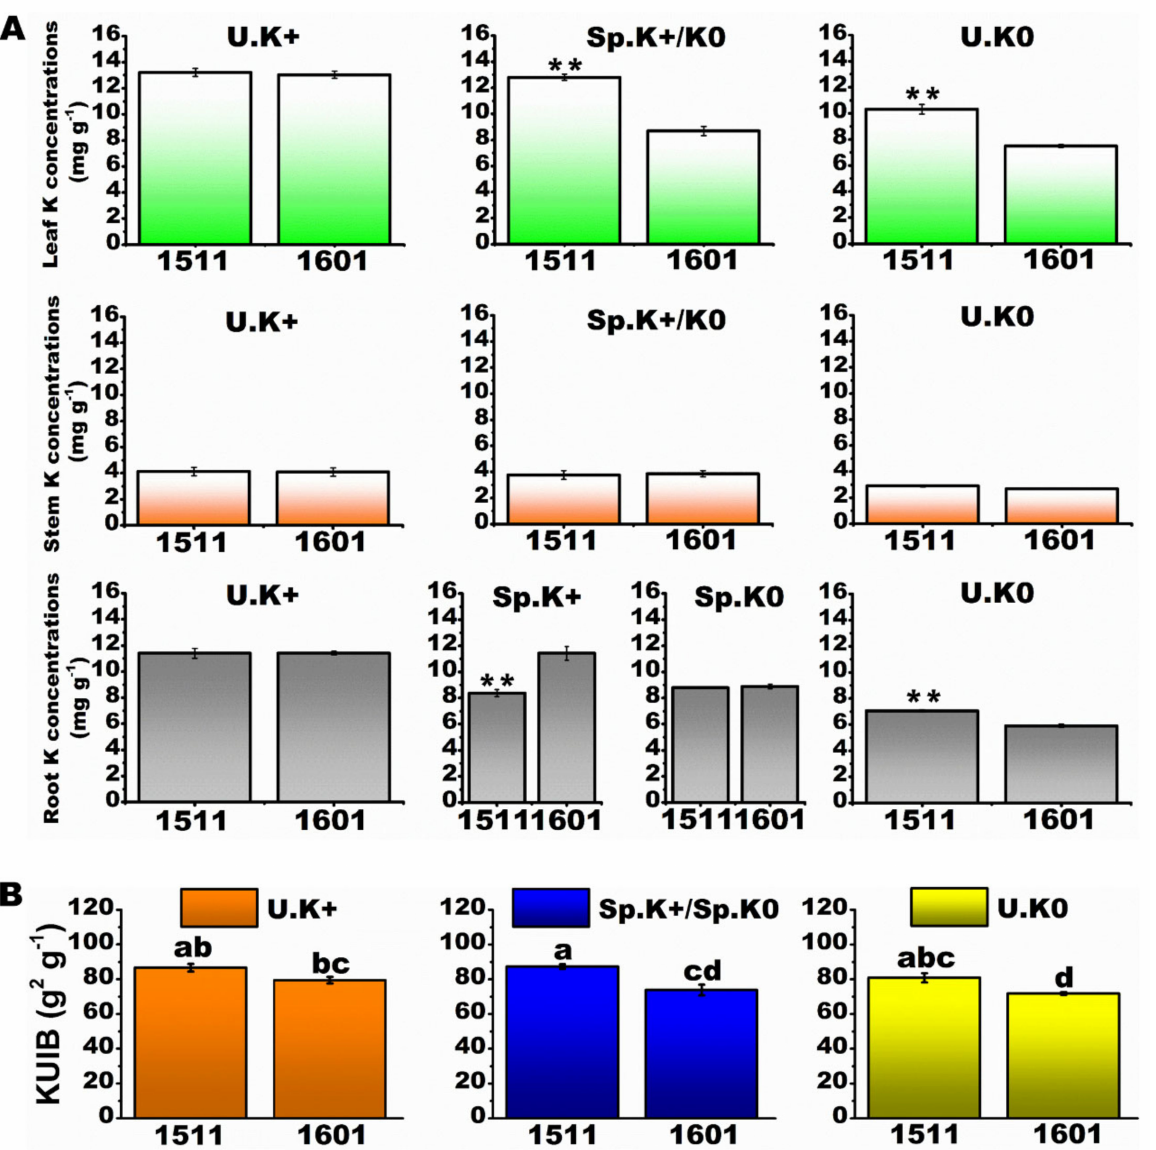
Figure 2. Growth of tea plants under heterogeneous and homogeneous K environments. K con- centrations in different tissues under different treatments ( A ). K biological utilization indexes of tea plants under different treatments ( B ). Data are means ± SE ( n = 3). Different letters represent significant differences at the level of p < 0.05. ** represents a highly significant difference between the two genotypes under p <